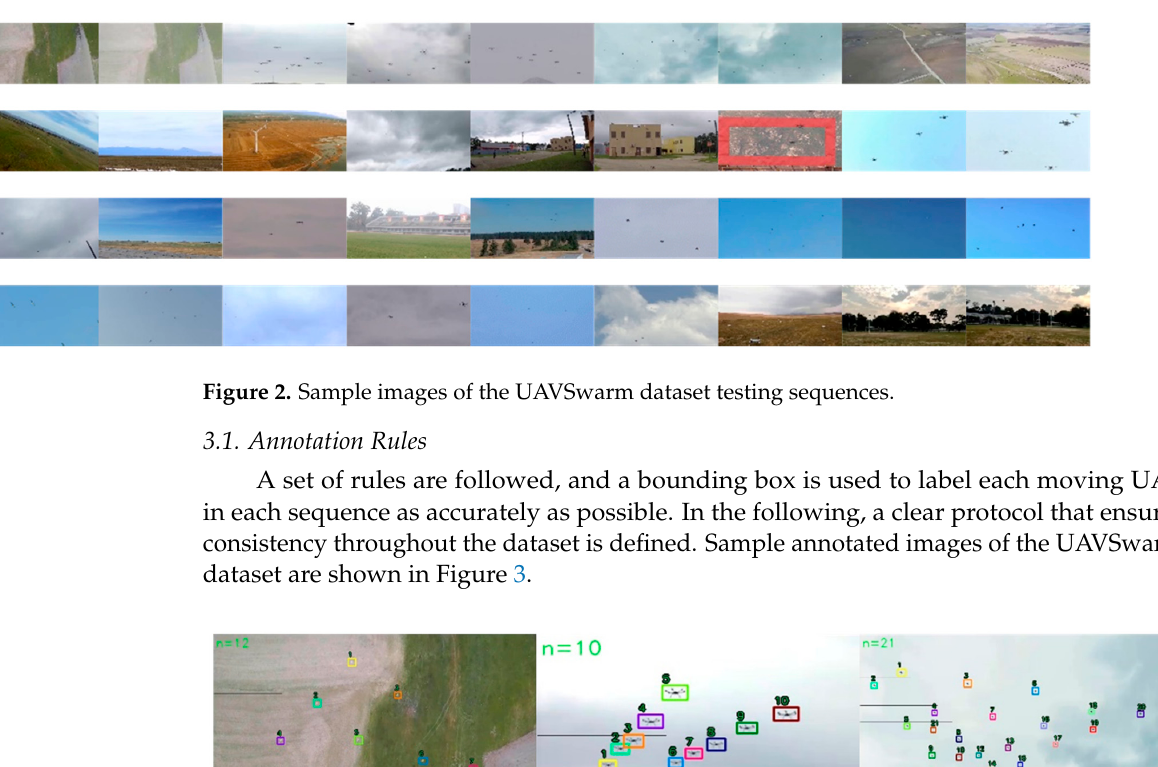
Figure 1. Sample images of the UAVSwarm dataset training sequences.